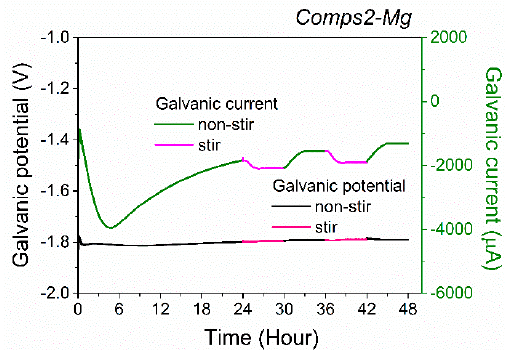
ff ect of stirring on galvanic corrosion of Comps2 / Mg Figure 6. Effect of stirring on galvanic corrosion of Comps2 / Mg couple. Figure 6. E